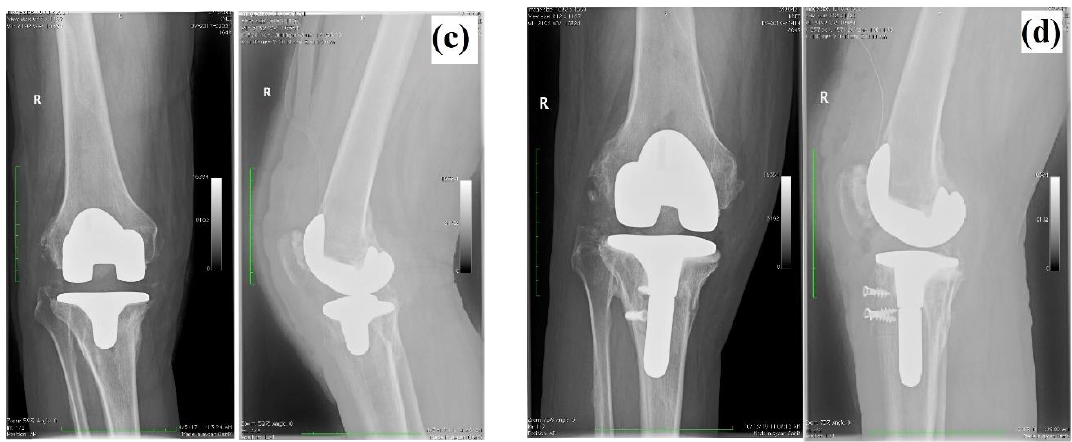
Figure 1. ( a ) Bilateral knee radiography—anteroposterior view, demonstrating advanced degenerative changes (gonarthrosis stadium IV) at the level of the right knee (white arrows), secondary to the malunion of tibial plateau fracture; ( b ) lateral view, showing depression of the lateral tibial plateau (white arrow); ( c ) anteroposterior and later view, eight years after surgery; both views highlight the loosening of the tibial component, minimal osteolysis of the medial tibial plateau (anteroposterior view) and minimal osteolysis around the distal region of the tibial implant (lateral view); ( d ) anteroposterior and lateral view after revision of the total knee arthroplasty using modular tibial implant with short stem and two screws for re-insertion of the patellar tendon (after tibial tuberosity osteotomy).